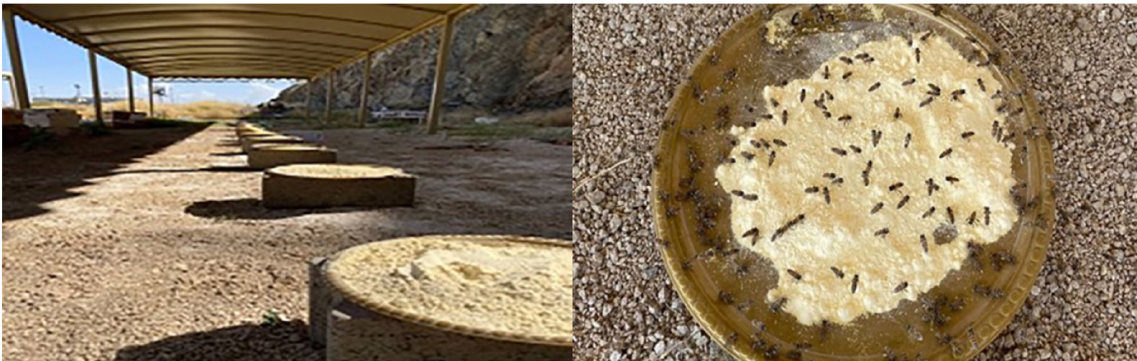
Figure 3. Different diet supplements at different distances (10, 25, and 50 m) away from the apiary and measuring the number of honey bees.